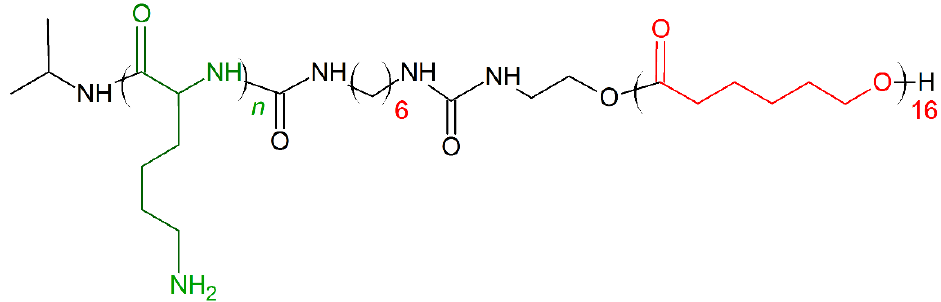
Figure 11. Schematic representation of Poly( ε -caprolactone) (PCL) 16 -b-K n polymer. Green: positively charged monomer; red: hydrophobic monomers.